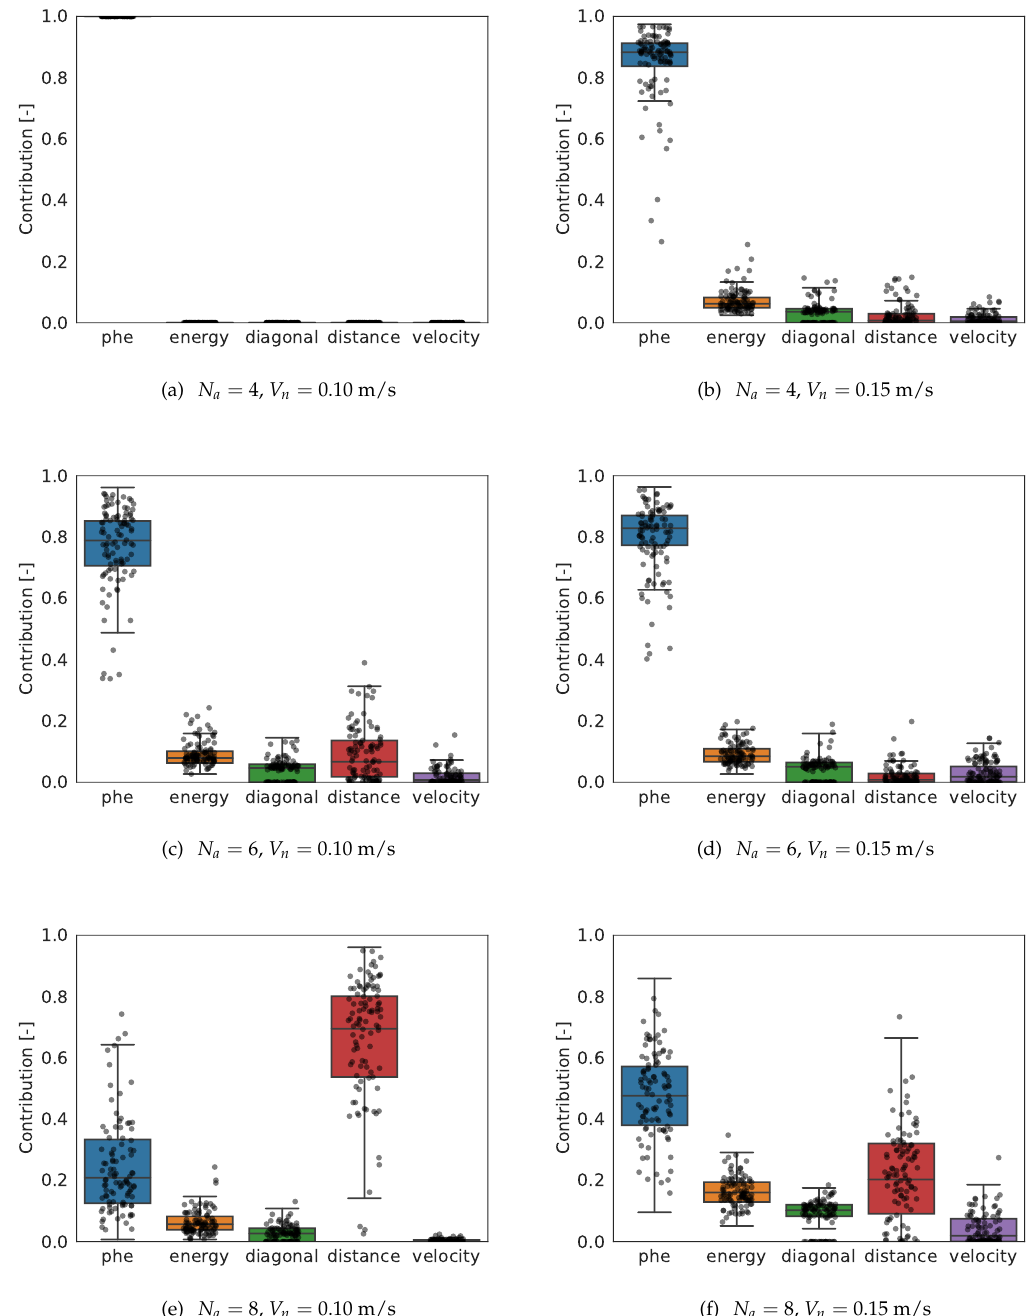
Figure 6. Normalized contribution of each behavior to the final decision as per Equations (18) and (19). The data has been extracted from 5 simulations and each decision taken by each agent. Some data (black dots) has been plotted as